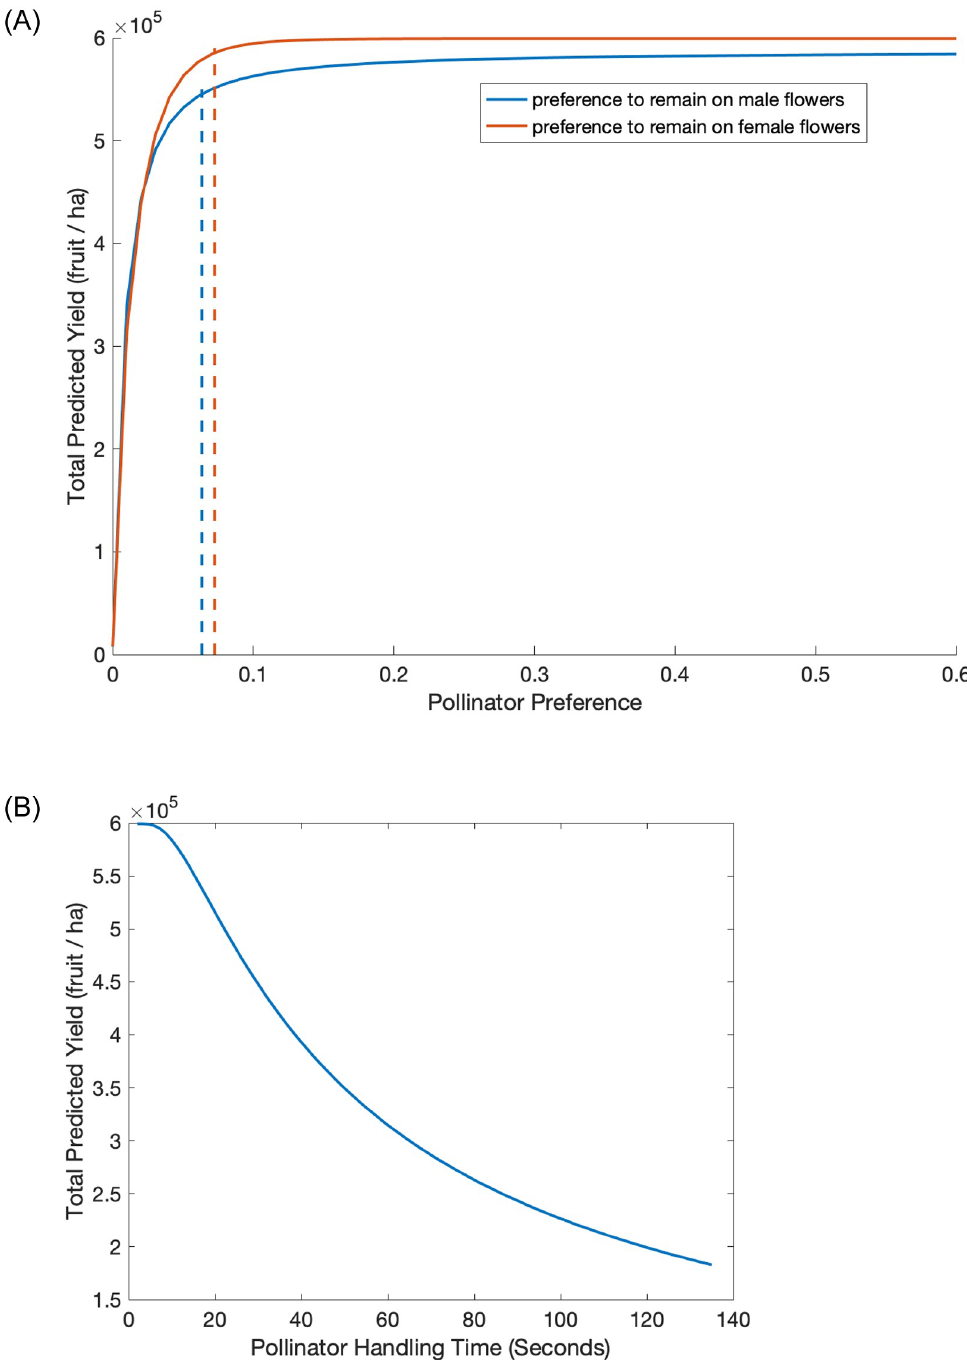
Fig 8. Total predicted yield for varying pollinators’ preference of flowers (a) and for varying pollinators’ handling time (b). Other parameters are baseline values in Table 2. Pollinators prefer flowers of the same sex in sequential visits; in (a) low preference values near 0 correspond with strong tendencies to remain on either male or female flowers, higher preference values correspond with strong tendicies to switch flower type. Blue dashed line in (a) depicts baseline values of δ (preference to remain on male flowers) and red dashed line depicts values of � (preference to remain on female flowers).